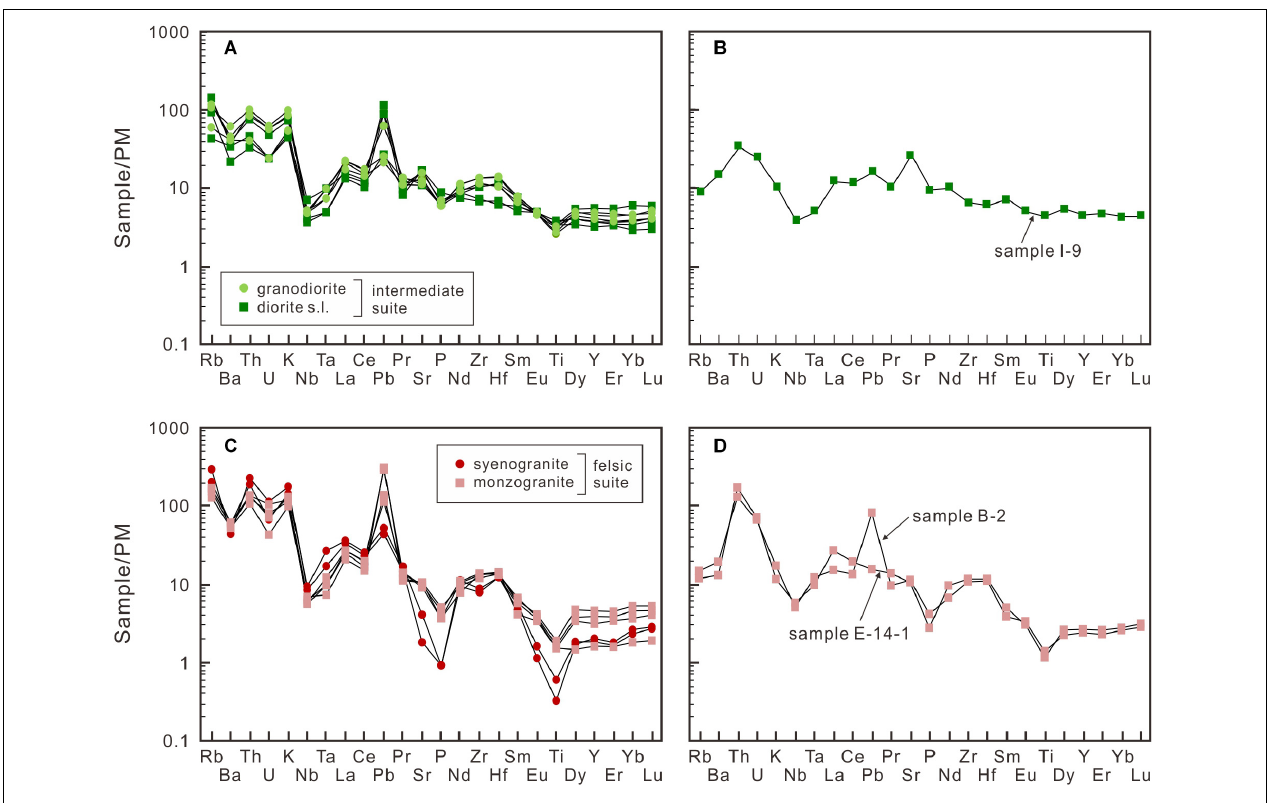
FIGURE 9 | Primitive mantle-normalized extended trace element patterns for the studied samples. (A) Intermediate suite. (B) A diorite (sample I-9) showing a different pattern from other samples of the intermediate suite. (C) Felsic suite. (D) Two monzogranites (samples E-14-1 and B-2) showing different patterns from other samples of the felsic suite. Normalizing values are after Sun and McDonough